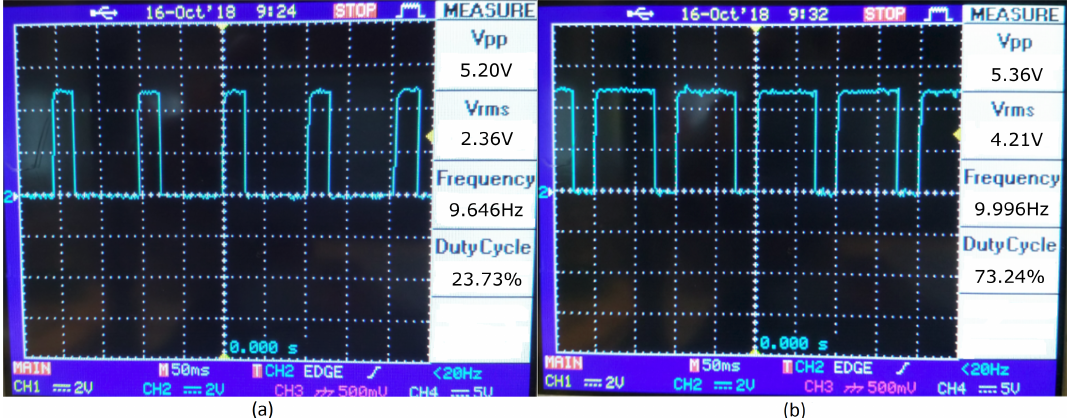
Figure 5. ( a ) Torque sensor with the coupler attached to the shaft. ( b ) Two permanent magnets attached to the coupler, connecting the shaft of the torque sensor to the gearbox. A Hall effect sensor acts as a switching device, which turns on/off when facing the magnets of different poles.